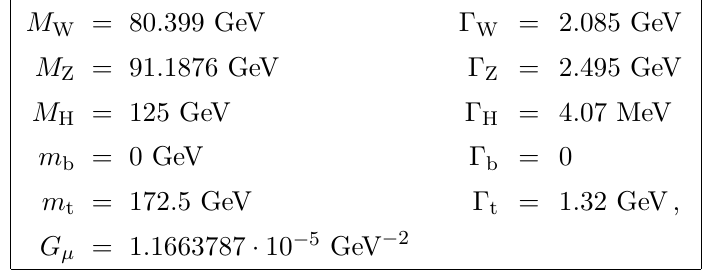
Table 1. Values of the various physical input parameters. The value of m b depends on the employed flavour-number scheme as discussed in the